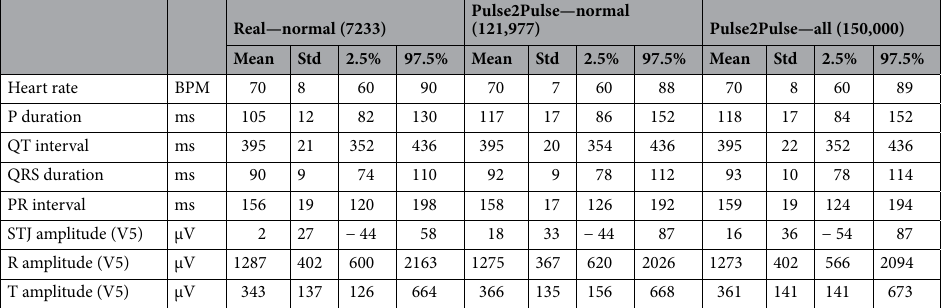
Table 2. Mean, standard deviation (std), 2.5%, and 97.5% percentile for standard ECG parameters in real and fake ECGs. BPM beats per minute.